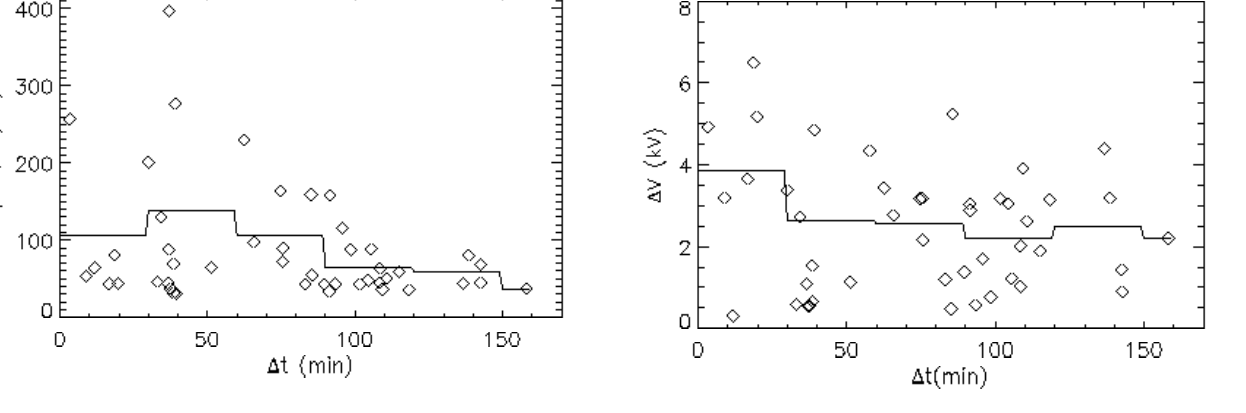
Fig. 3. Distribution of the maximum electric field poleward compo- nent corresponding to a SAID event ( E pw ), versus time after sub- storm onset ( 1t ). The solid line represents the average E pw value calculated over 30-min intervals.